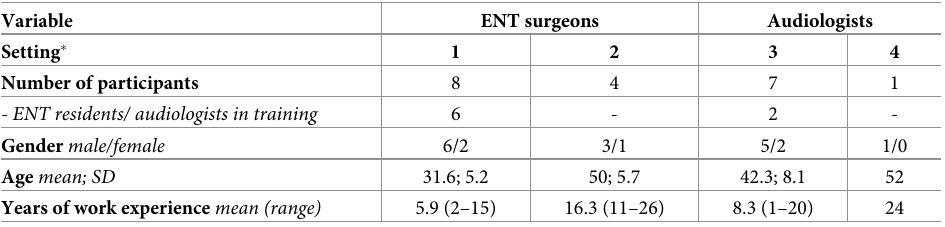
Table 1. Characteristics of the Hearing Health Professionals (N = 20) participating in the study.